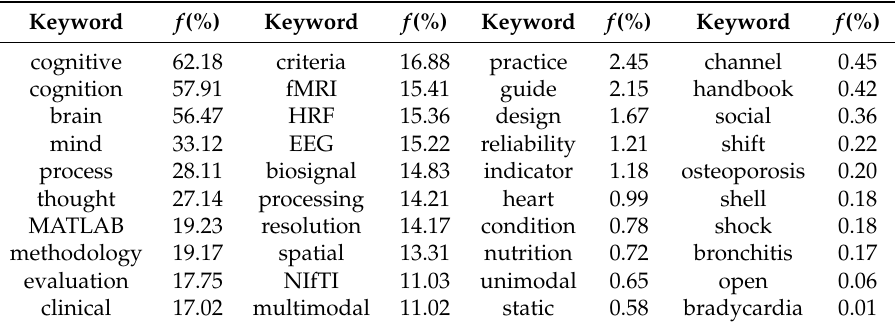
Table 10. Collection keywords (frequency f as a